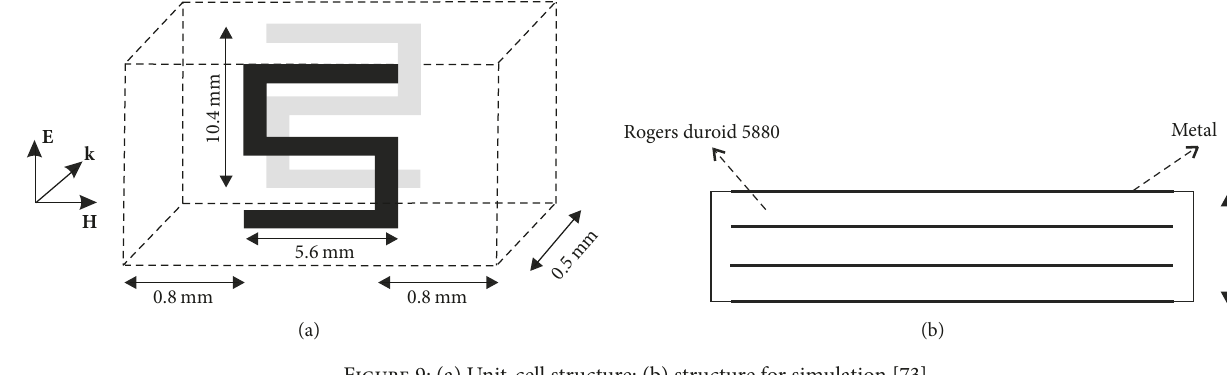
Figure 9: (a) Unit-cell structure; (b) structure for simulation [73].